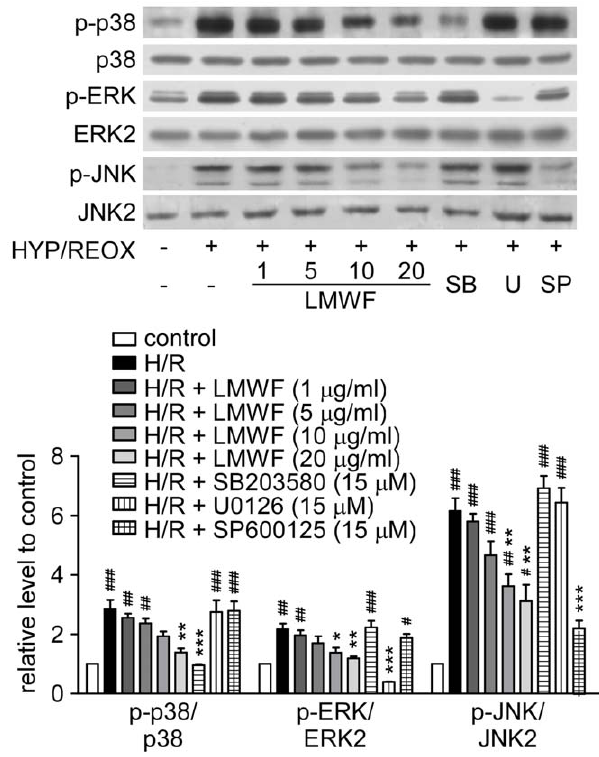
Figure 6. LMWF inhibited MAPK signaling pathways in HK2 cells exposed to hypoxia-reoxygenation. Expression and phos- phorylation levels of ERK, p38, JNK of HK2 cells exposed to hypoxia for 12 h followed by reoxygenation for 30 min with 1 , 20 m g/ml LMWF or MAPK inhibitors, SB-203580 (SB), U-0126 (U), SP-600125 (SP), at 15 m M were detected by Western blot analysis. Representative blottings ( up ) and relative ratios of protein levels ( down ) are shown. Each bar represents the mean 6 SEM. n = 3; # P , 0.05, ## P , 0.01, ### P , 0.001 vs. control, *P , 0.05, ** P , 0.01, *** P , 0.001 vs. hypoxia- reoxygenation